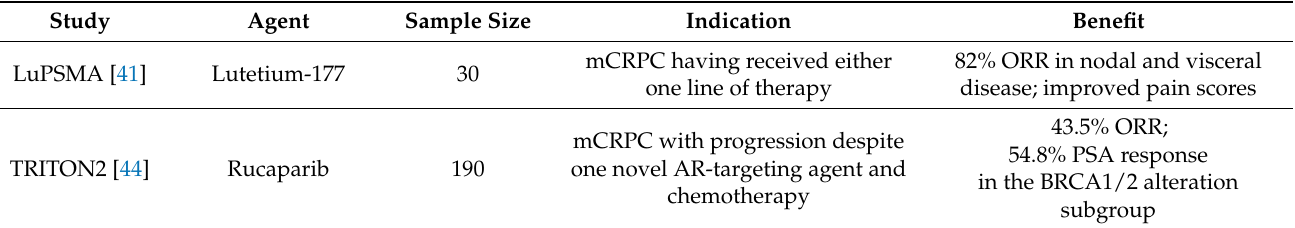
Table 3. Summary of the other mCRPC treatment